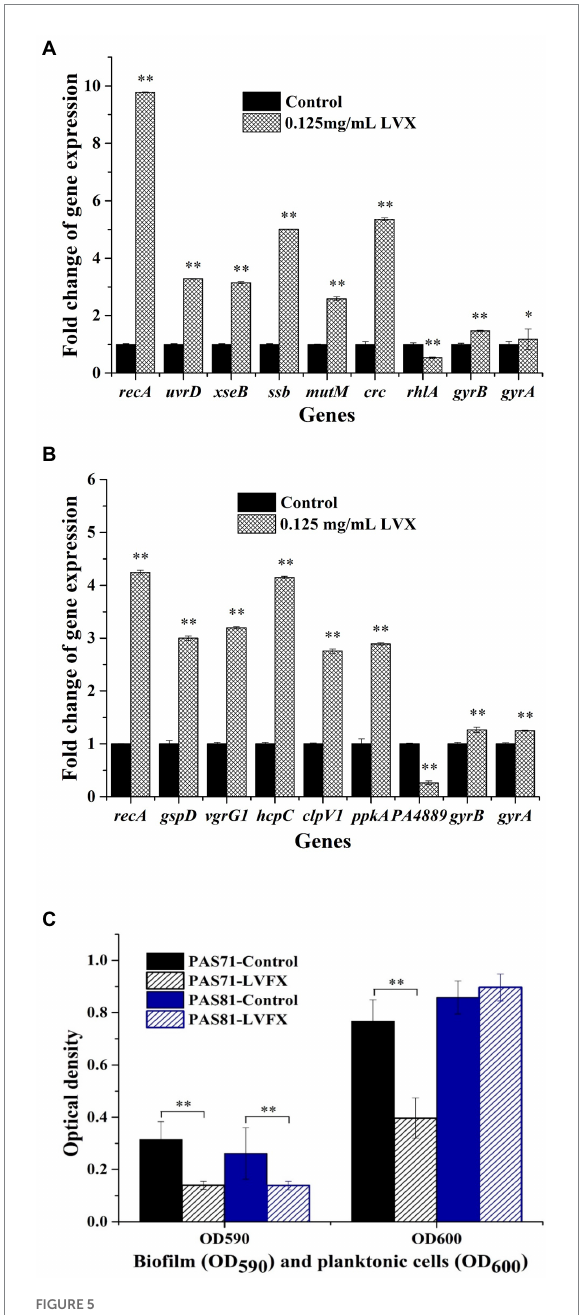
FIGURE 5 qRT-PCR and biofilm validation maps for Pseudomonas aeruginosa PAS71 and PAS81 strains. (A) qRT-PCR validation map for a selection of the differentially expressed key genes from PAS71 strain when exposed and unexposed to 0.125 μ g/ml LVX for 5 h; (B) qRT-PCR validation map for the selection of differentially expressed key genes from PAS81 strain when exposed and unexposed to 0.125 μ g/ml LVX for 5 h; (C) biofilm validation map for PAS71 and PAS81 strains exposed and unexposed to 0.125 μ g/ ml LVX for 24 h. * p < 0.05 based on an independent Student’s t -test; ** p <